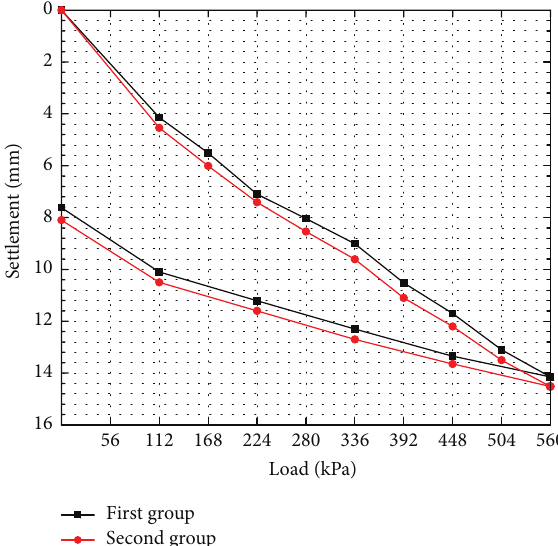
Figure 4: 𝑃 - 𝑆 curve of single pile CFG composite foundation.